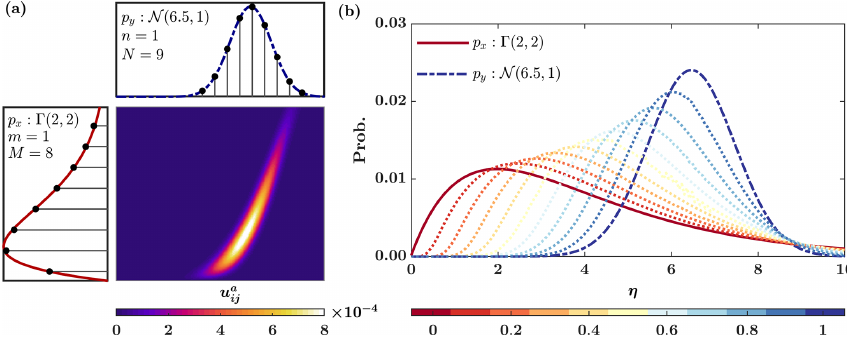
Figure 1. Interpolation between two Gaussian distributions N (µ 1 ,σ 2 0 . 01 act as a function of the interpolation or displacement parameter η ∈ [ 0 , 1 ] for the (a) Hellinger distance, (b) Kullback–Leibler divergence, and (c) 2-Wasserstein distance (Peyré and Cuturi, 2019)